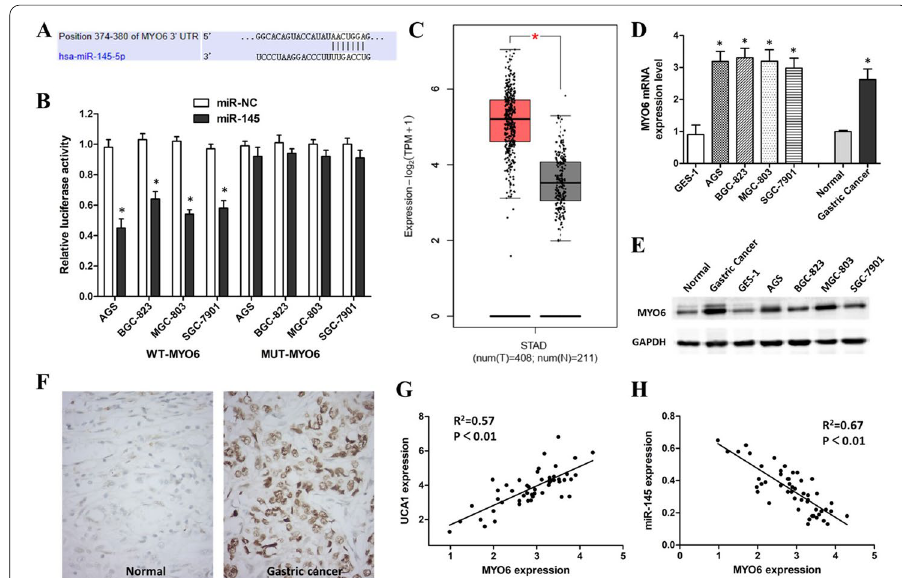
databases. D Q-PCR showing MYO6 expression level in GC cell lines and tissues. E Western blot showing MYO6 expression level in GC tissues and cell lines. F IHC showing MYO6 expression level in GC tissues. G Scatter diagram showing a positive correlation of UCA1 and MYO6 in GC tissues by Q-PCR. H Scatter diagram showing a negative correlation of miR-145 and MYO6 in GC tissues by Q-PCR. *p < 0.05, compared with control cells or